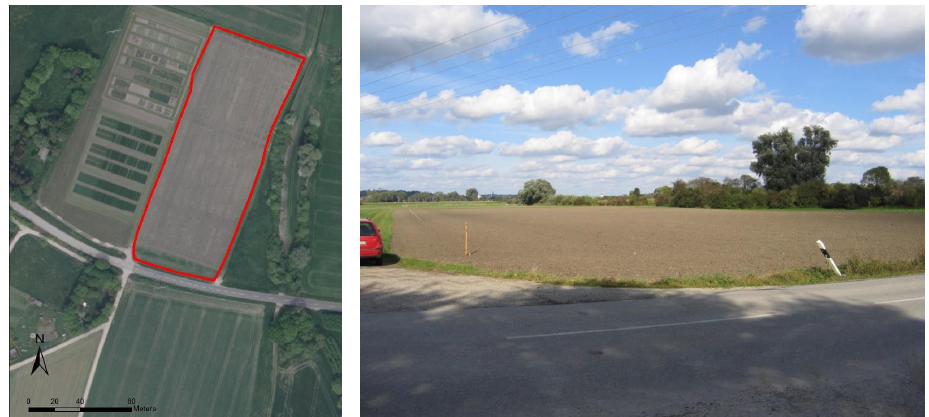
Figure 1. Aerial image and picture of the position of the field (Pulling 8) in the landscape.